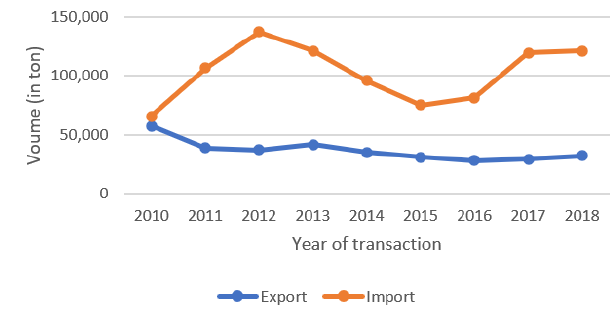
Figure 2. Tobacco Export and Import (2010-2018) [49].